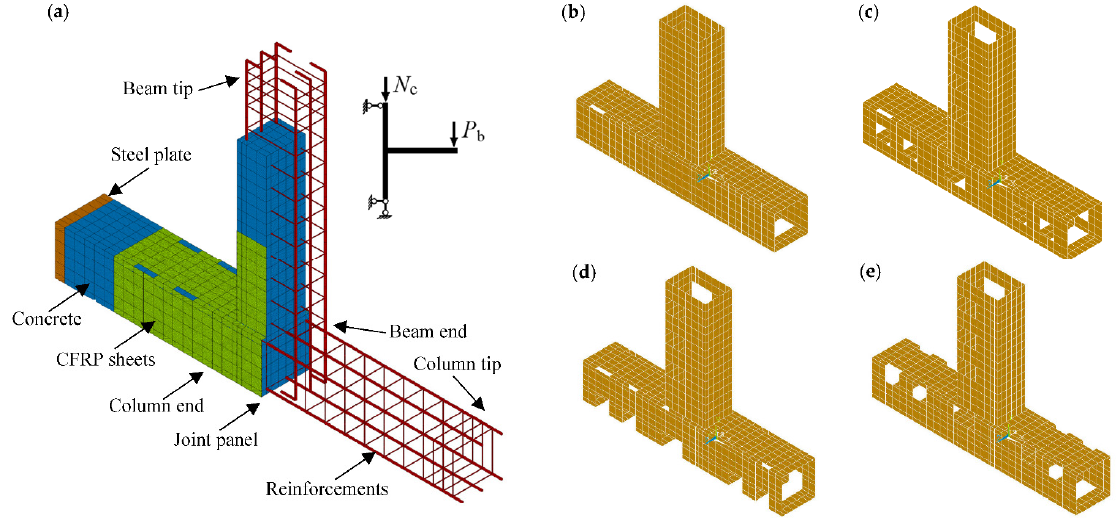
Figure 4. FE models. ( a ) A typical FE model created in ANSYS; ( b ) CFRP system of Specimen TJ-3; ( c ) CFRP system of Specimen DM21015; ( d ) CFRP system of Specimen DE21015; ( e ) CFRP system of Specimen DI21015.